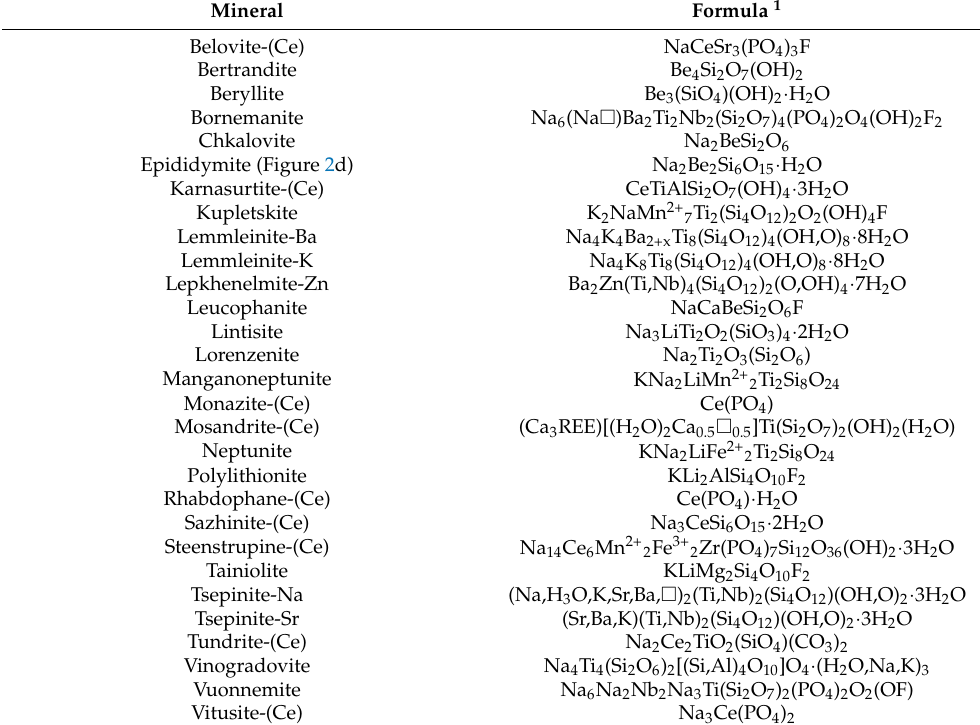
Table 2. List of rare metal minerals from pegmatites spatially related to poikilitic rocks [25,28].